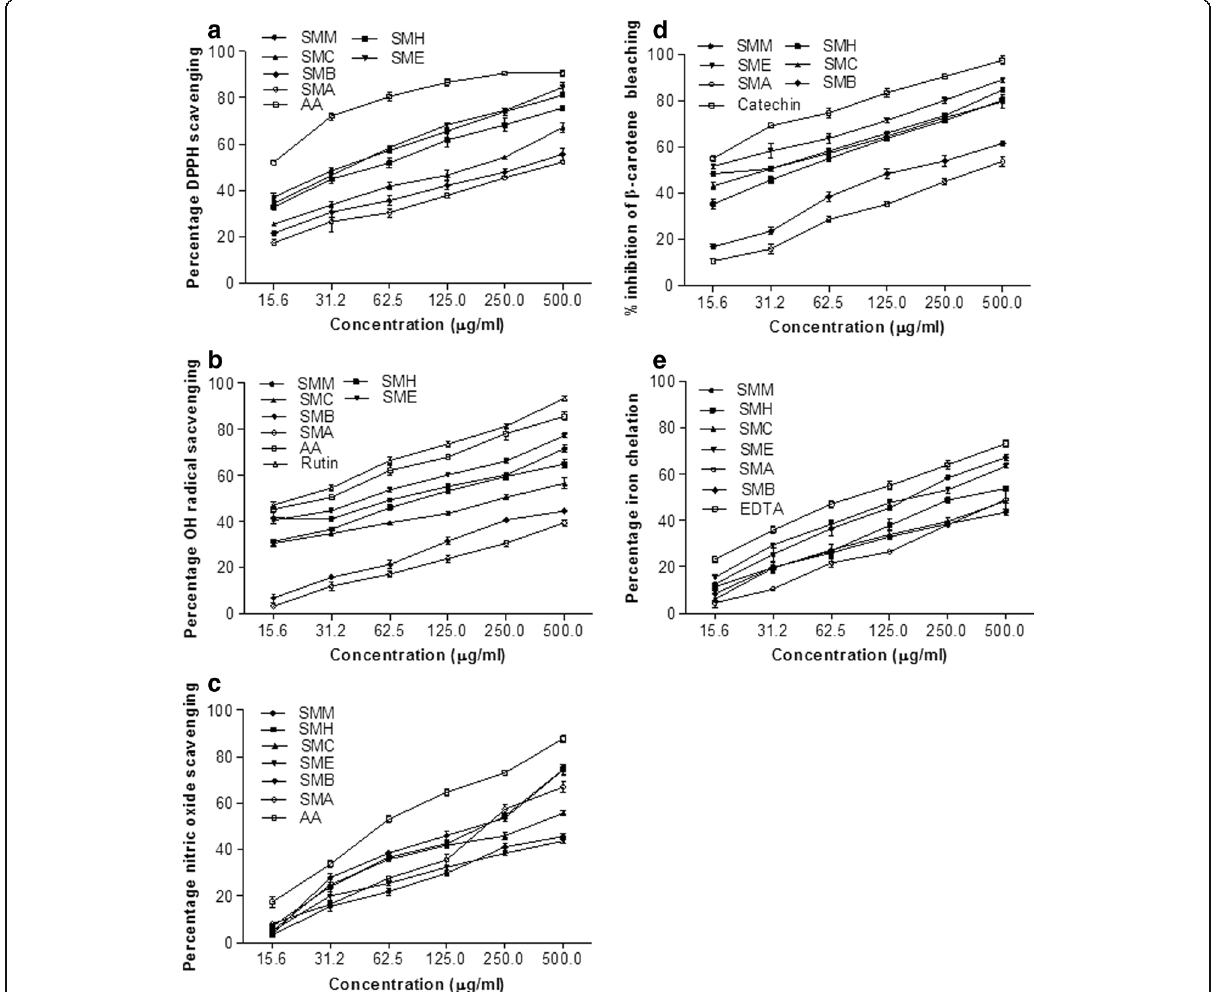
Fig. 1 In vitro antioxidant activities of the methanol extract of the stem bark of S. mukorossi and its derived fractions. ( a ) DPPH scavenging activity; ( b ) hydroxyl radical scavenging activity; ( c ) nitric oxide scavenging activity; ( d ) inhibition of carotene bleaching assay; ( e ) iron chelation activity. SMM, S. mukorossi methanol extract of stem bark; SMH, n-hexane fraction of SMM; SMC, chloroform fraction of SMM; SME, ethyl acetate fraction of SMM; SMA, soluble residual aqueous fraction of SMM; AA, ascorbic acid. Data represent mean (3) ± SD